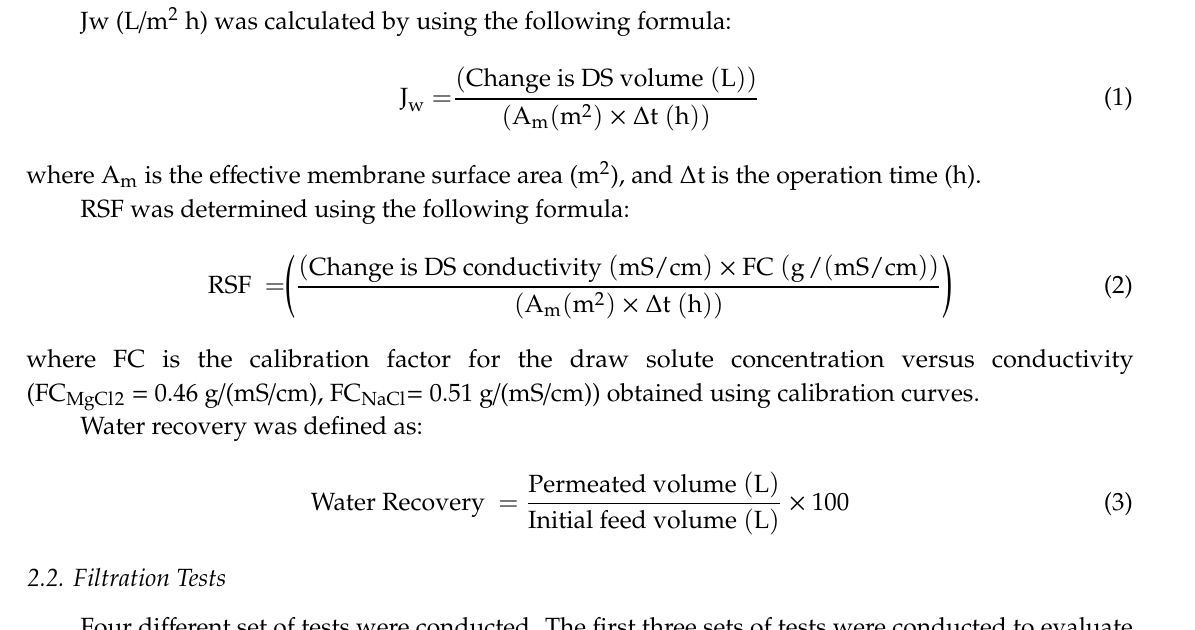
Figure 1. Schematic diagram of the forward osmosis (FO) bench-scale set-up. Arrows in the tank describe changes in volumes during the FO concentration process.